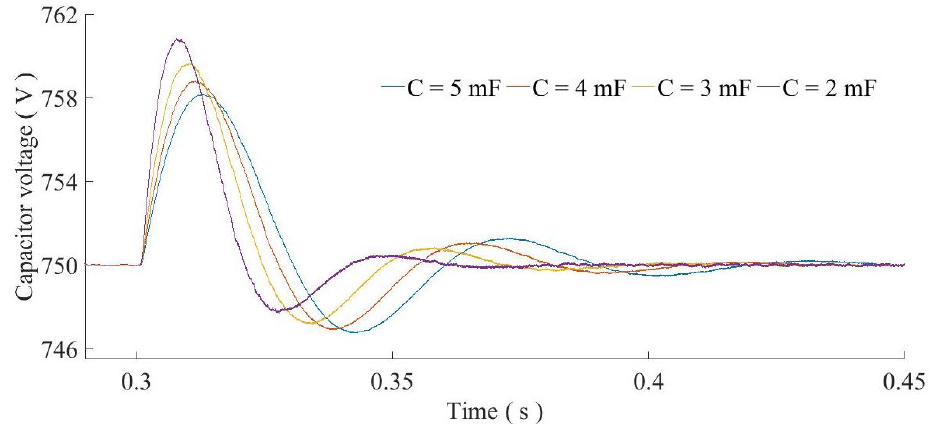
Figure 10. Influence of C on dynamic performance of the DDPS.